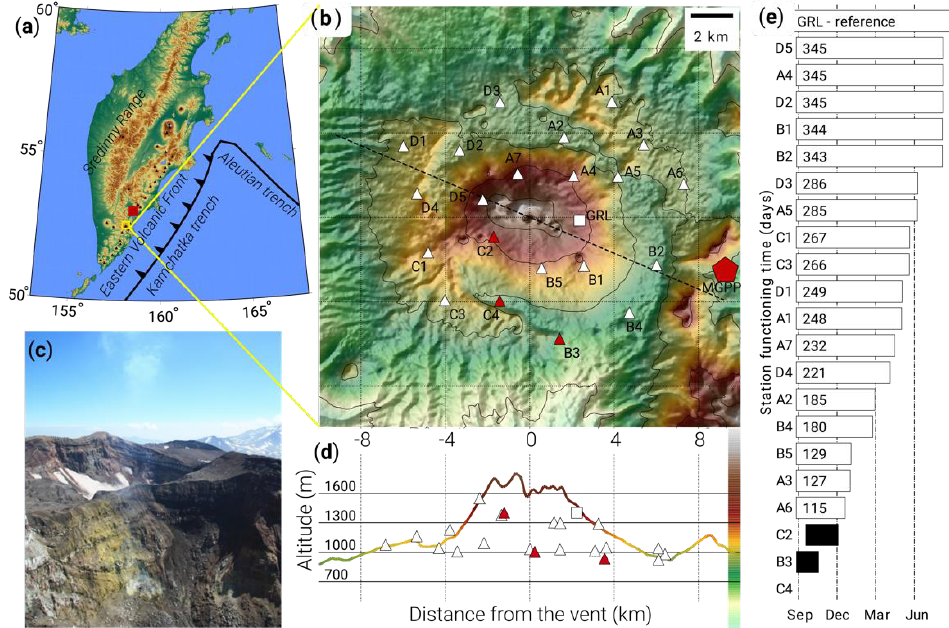
Figure 1. Gorely temporary seismic network (August 2013–August 2014) in the context of study region: ( a ) map of the Kamchatka peninsula with main tectonic features (red square indicates the city of Petropavlovsk-Kamchatsky, black triangles—active volcanoes and yellow square marks Gorely study region); ( b ) network geometry along with volcano topography (white triangles are stations used for analysis, white square—permanent GRL station, red triangles—nonfunctional stations, red pentagon—Mutnovsky Geothermal Power Plant); ( c ) photo of the volcanic vent taken during network installation process from the active crater edge; ( d ) projection of station locations on volcanic edifice along the dashed line; ( e ) data recovery chart sorted according to station functioning time.